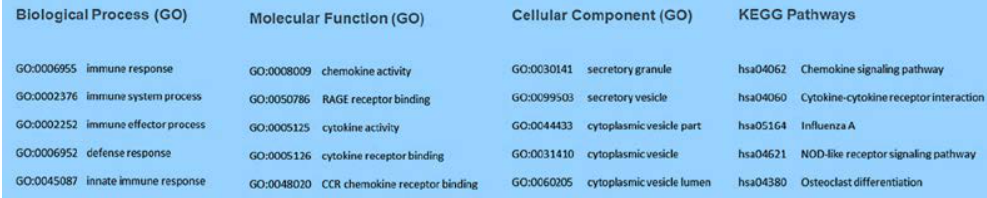
Fig. 3. Functional Enrichment analysis (top five GO terms and pathways) in the network involving all the three components of Gene Ontology and KEGG